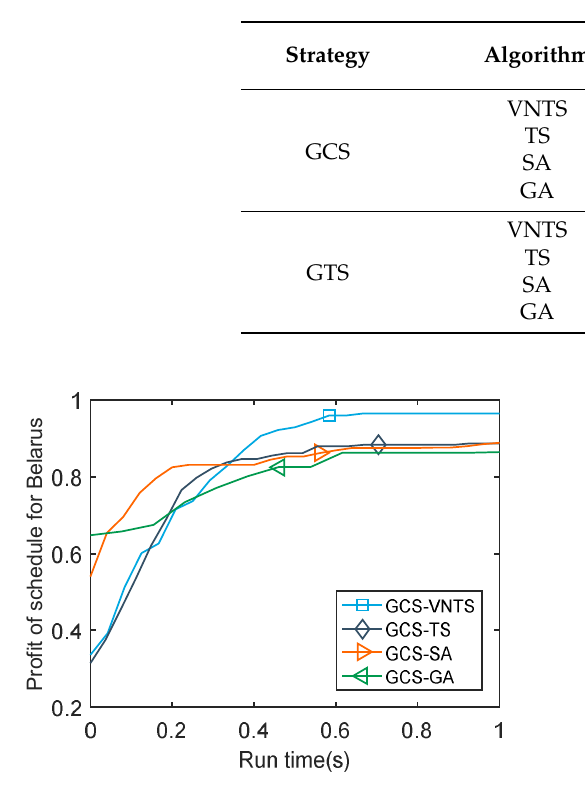
Table 4. Simulation results of four algorithms under GCS and GTS methods.